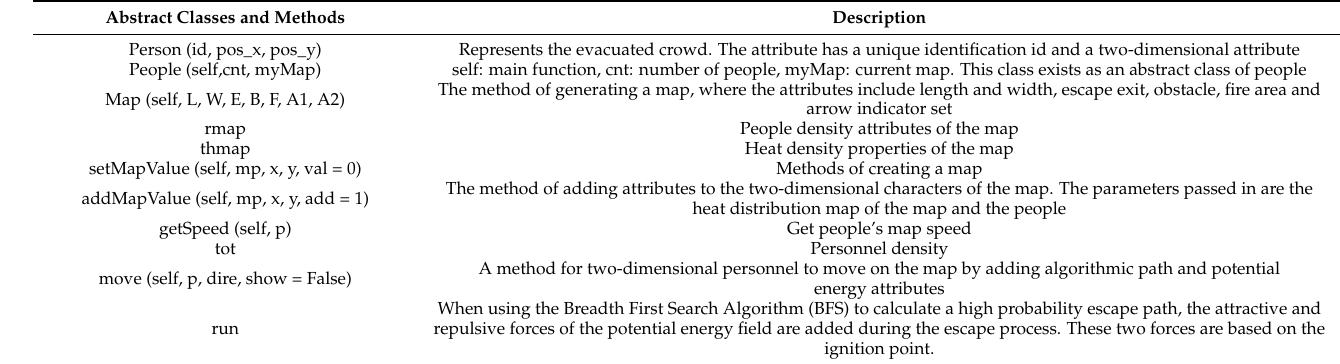
Table 1. Core Procedures of the Intelligent Evacuation